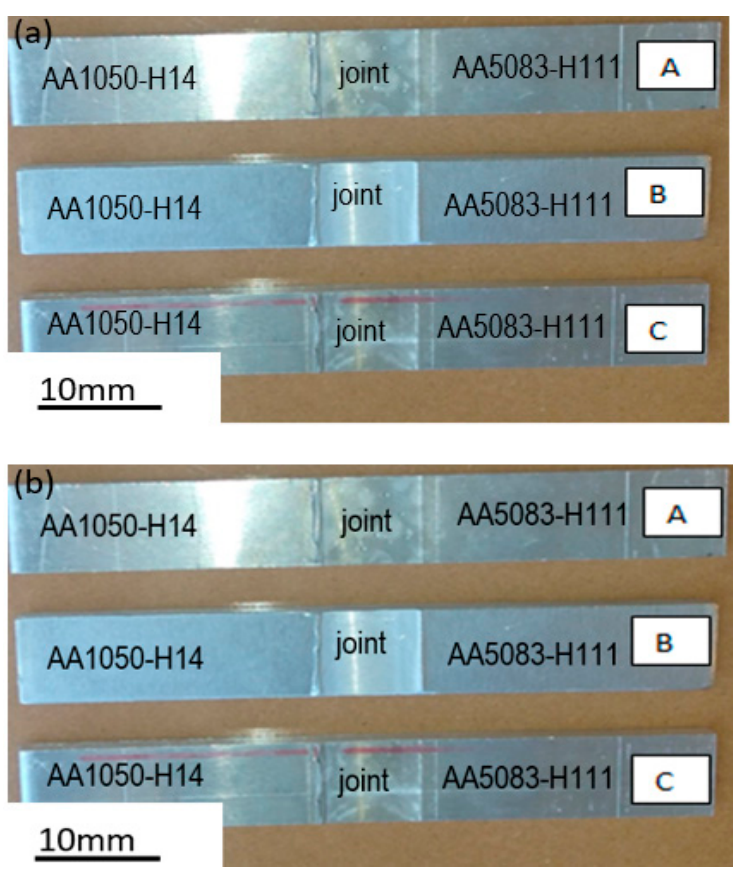
Figure 8. Bending specimens, ( a ) face; ( b ) root.